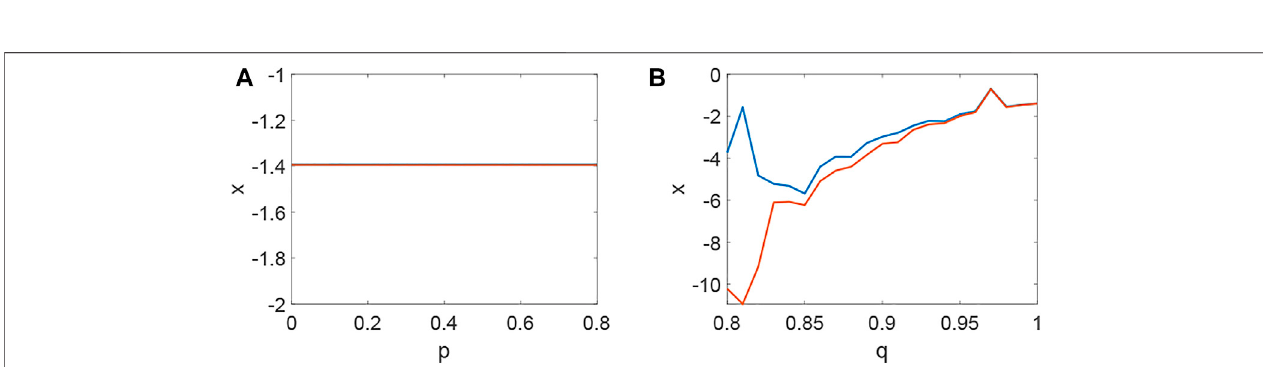
FIGURE 6 | The stability of system (1) when p = 0.1, q = 0.82, τ = 0. (A) The distribution of eigenvalues Λ i (labeled by *). (B) Turing instability occurs in system (1) when some eigenvalue Λ i make H 3 < 0 hold.